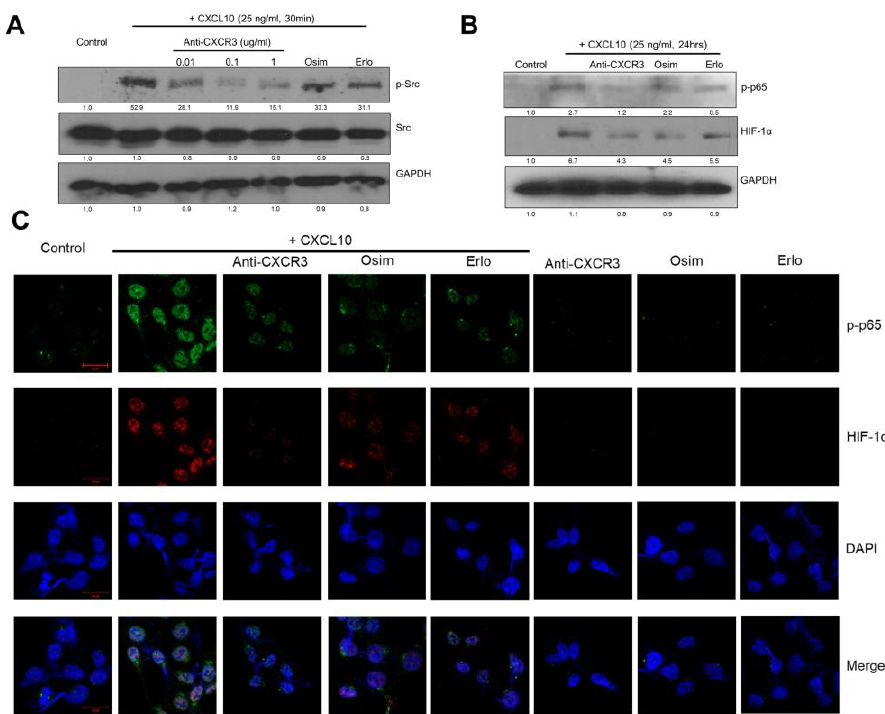
Figure 3. Activation of the oncogenic CXCR3-Src pathway in EGFR-mutant lung cancer cells by CXCL10. The expression of p-Src, p-STAT3, p-p65, and HIF-1 α from HCC4006 whole cell lysates was detected with Western blotting. To explore the oncogenic CXCR3 pathway, we pretreated HCC4006 cells with 0.01–1 µ g/mL anti-CXCR3 antibody for 2 h, 5 nM osimertinib for 24 h, and 50 nM erlotinib for 24 h, then administered treatment with 25 ng/mL CXCL10 for 30 min ( A ) or 24 h ( B ). ( A ) CXCL10 stimulated p-Src expression, and anti-CXCR3 antibody decreased p-Src expression, in a dose-dependent manner. Neither osimertinib nor erlotinib affected the expression of p-Src. ( B , C ) p- STAT3, p-p65, and HIF-1 α , analyzed by Western blotting ( B ) and immunofluorescence. Increased localization of p-p65 (green) and HIF- 1 α (red) in the nuclei was observed ( C